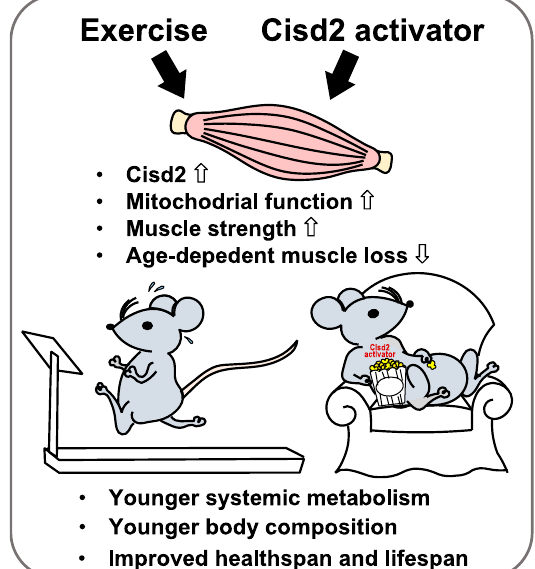
Figure 3. Beneficial effects of exercise and Cisd2 overexpression delay aging. Exercise induces expression of Cisd2, as well as other mitochondrial proteins, in skeletal muscle. Both exercise and Cisd2 overexpression lead to improved mitochondrial function, greater muscle strength and reduced aging-associated muscle loss. They further bring about a reversal of the systemic metabolism and body composition changes associated with aging and return the mice to a status closer to that of young individuals. Taking the evidence together, it seems that exercise and Cisd2 activation are two very promising strategies as an individual ages to build a healthy lifespan.